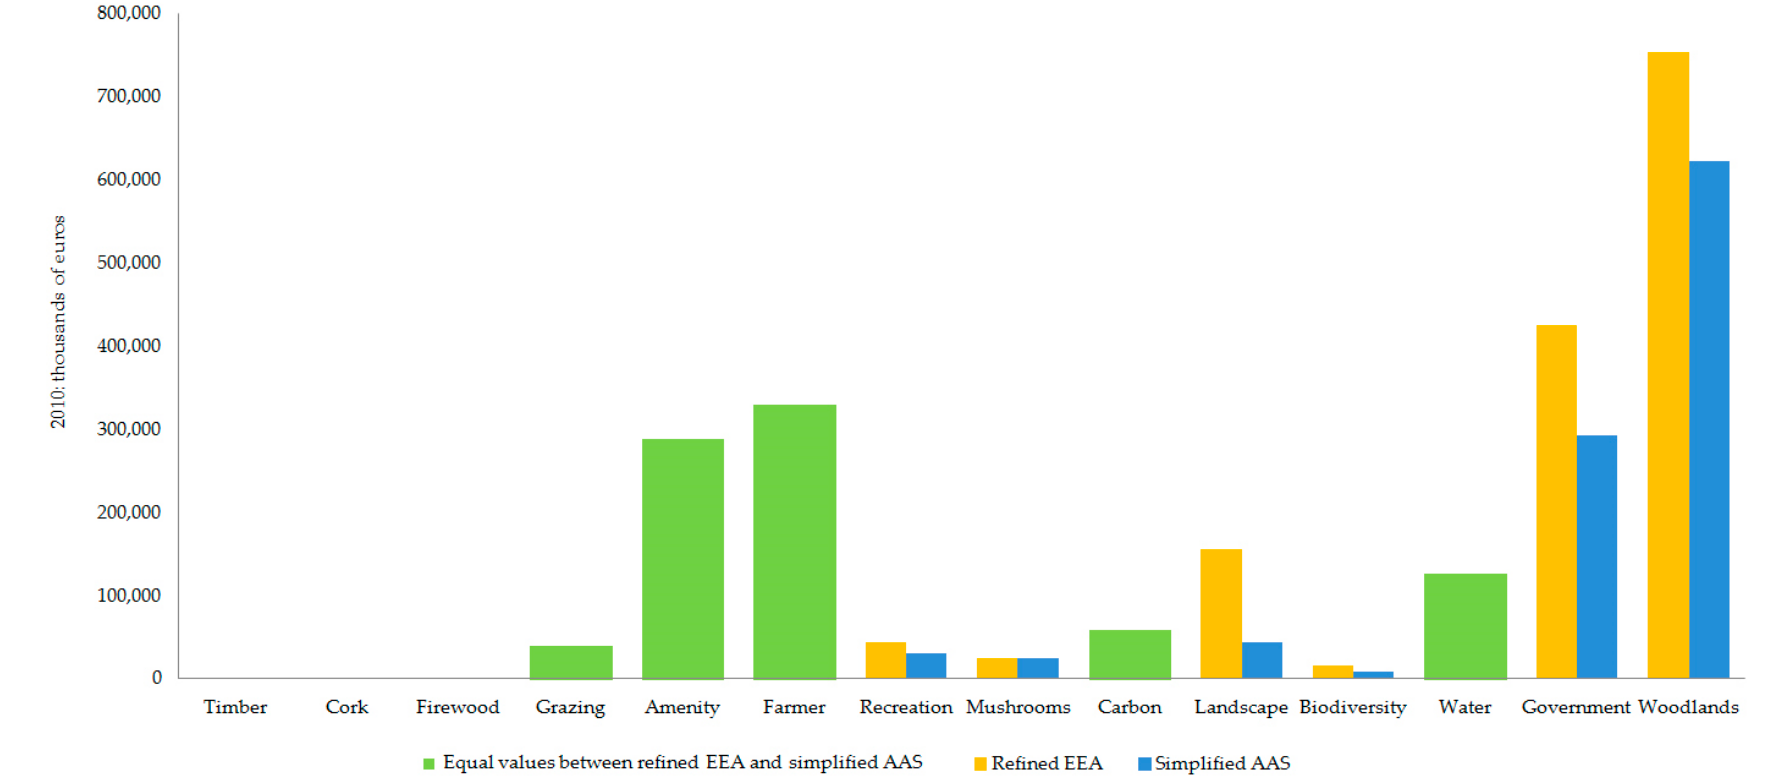
Figure 4. Ecosystem accounting: individual ecosystem services measured by refined EEA and simplified AAS in holm oak open woodlands in Andalusia, Spain, (2010: thousands of euros). rSNA is the refined System of National Accounts, rEEA is the System of Environmental Economic Accounting–Experimental Ecosystem Accounting, and sAAS is the simplified Agroforestry Accounting System. Source : Own elaboration based on [8]. Andalusian holm oak woodland surface: 1,408,170 hectares.